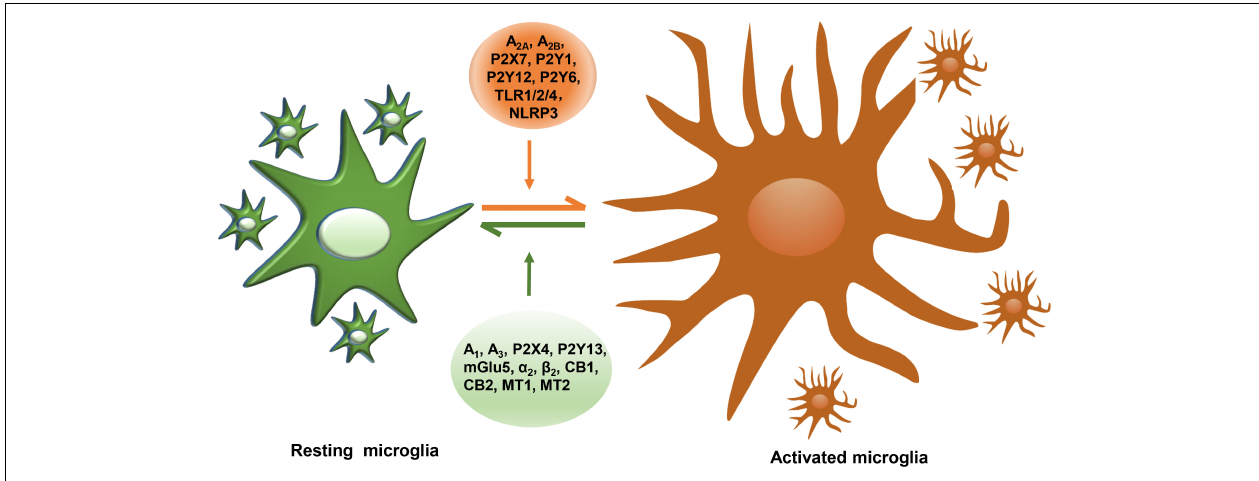
FIGURE 1 | The summary of reported microglial GPCRs in microglial activation of PD. GPCRs expressed in microglia containing A 2A , A 2B , P2X7, P2Y1, P2Y12, P2Y6, TLR1/2/4, and NLRP3 act as detrimental roles, promoting microglial activation, damaging DA neurons, while microglial A 1 , A 3 , P2X4, P2Y13, mGlu5, α 2 , β 2 , CB1, CB2, MT1, and MT2 play protective roles in